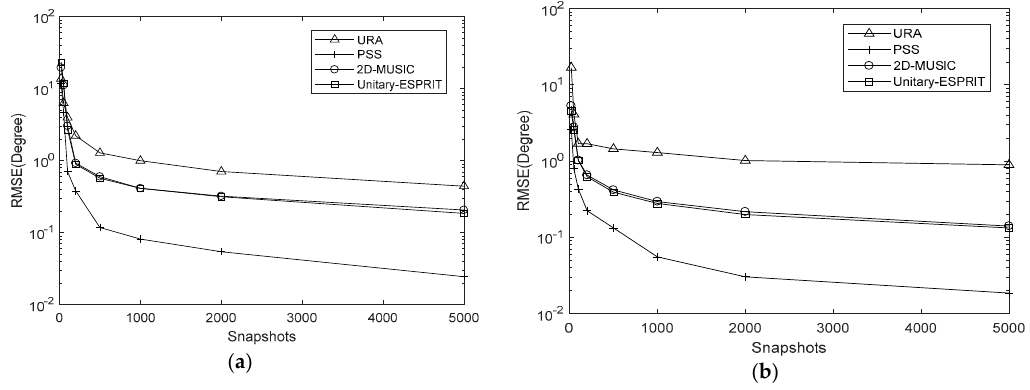
Figure 10. RMSE comparison under different snapshots with K = 7, ∆ θ = ∆ ϕ = 0.5 ◦ ( a ) azimuth ( b ) elevation.